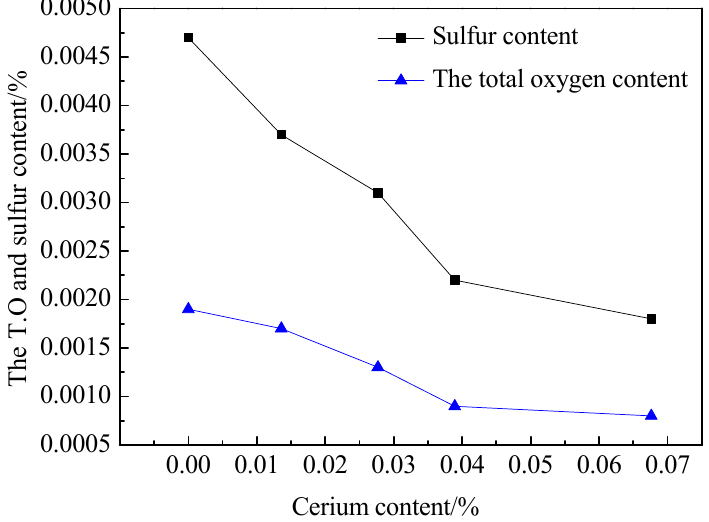
Figure 2. Comparison of the S and total oxygen (T.O) mass fraction in different cerium contents.